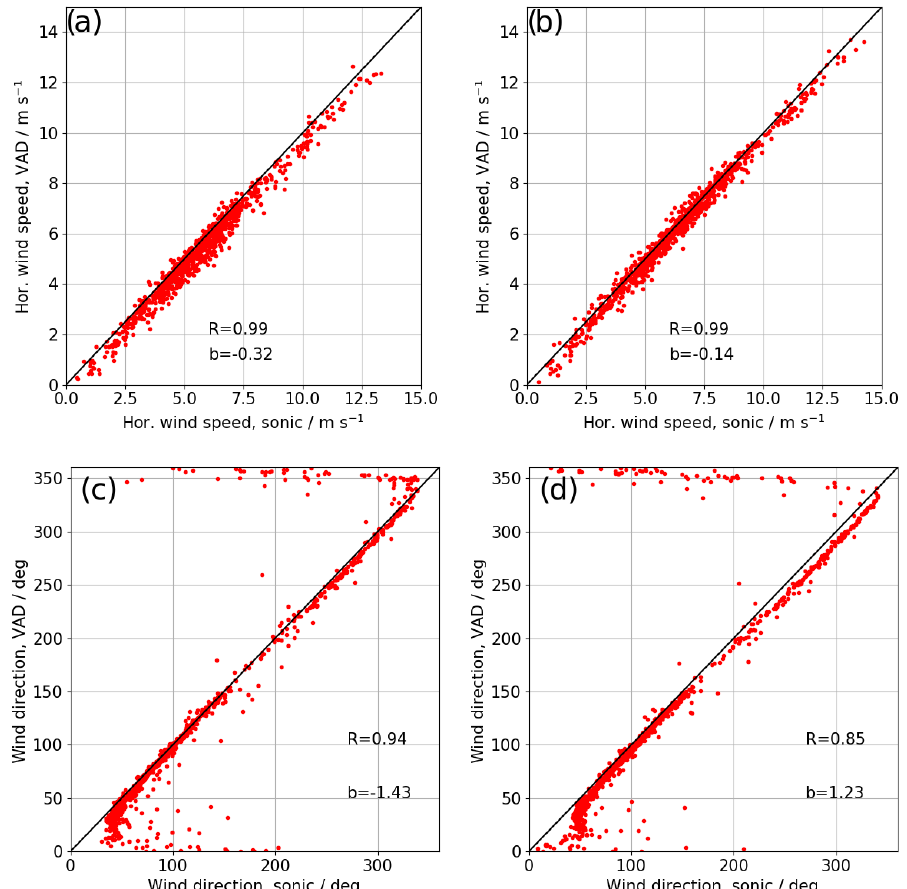
Figure D1. Scatterplot of horizontal wind speed (a, b) and wind direction (c, d) retrieved from lidar measurements compared to sonic anemometer measurements at 50m (a, c) and 90m (b, d)